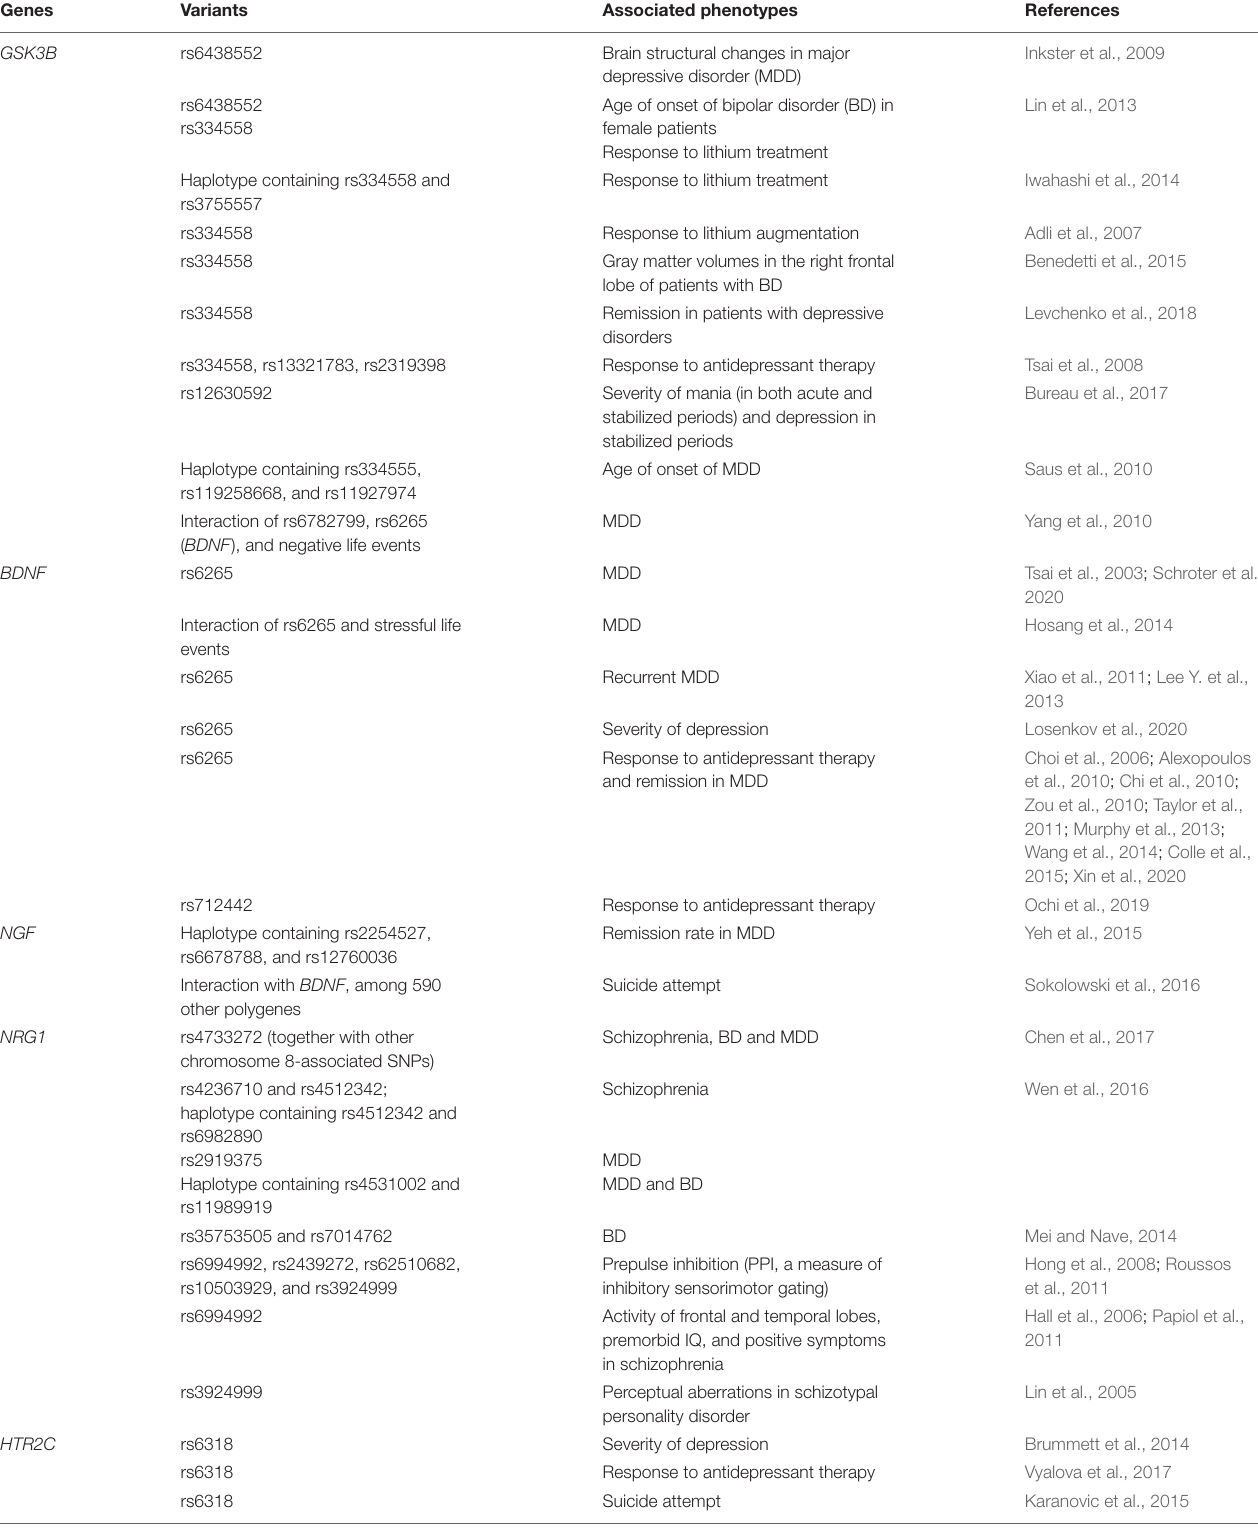
TABLE 1 | Previous reports of association between the six sequenced genes and psychiatric phenotypes, including response to